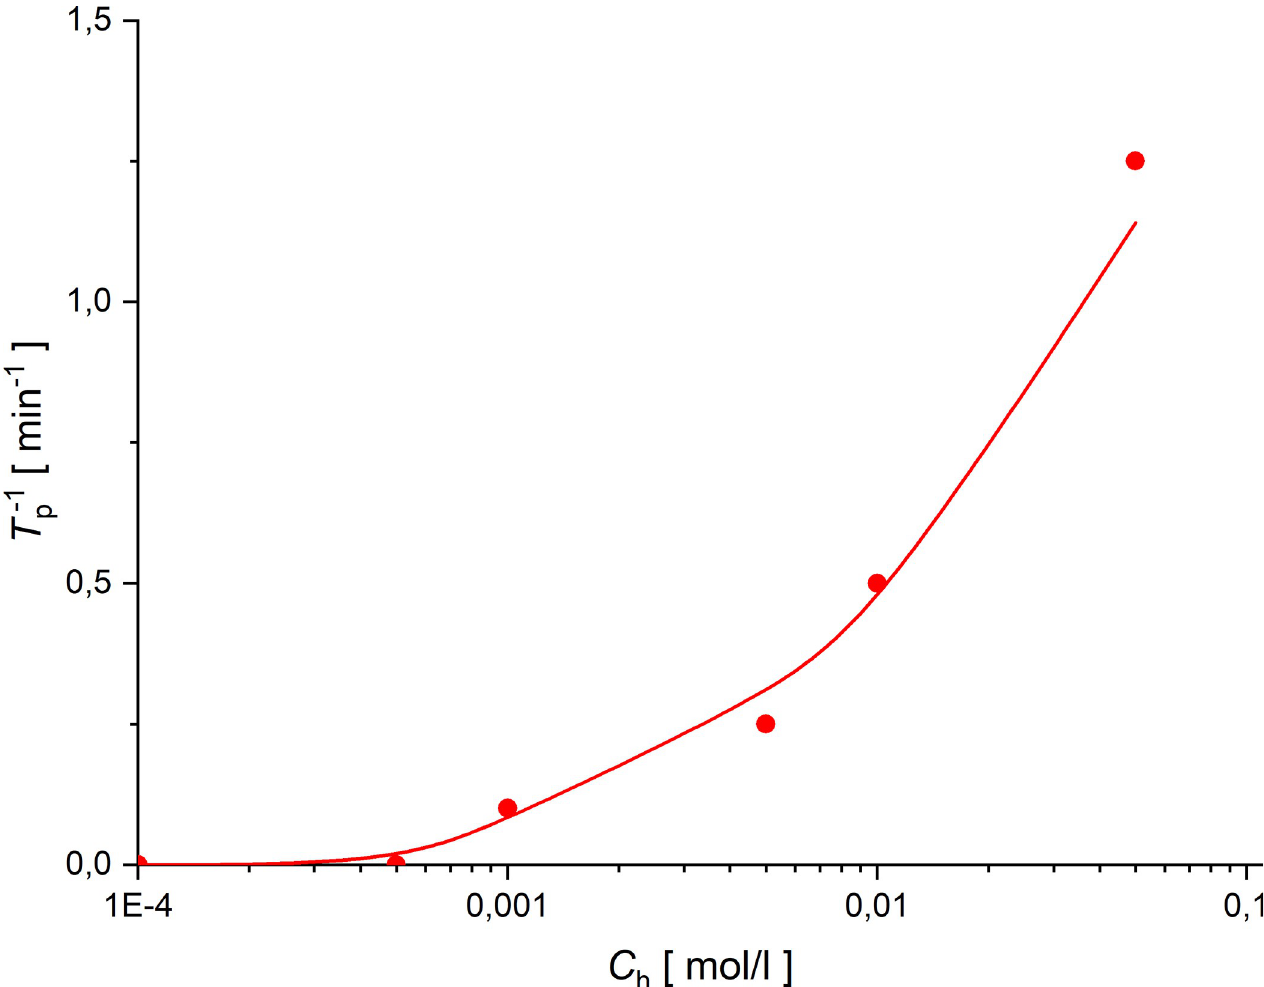
Fig 11. Inverse of time of appearance of hydrodynamic instability as a function of initial concentration C h ( C l = 10 − 5 mol/l) for configuration B of the membrane system.